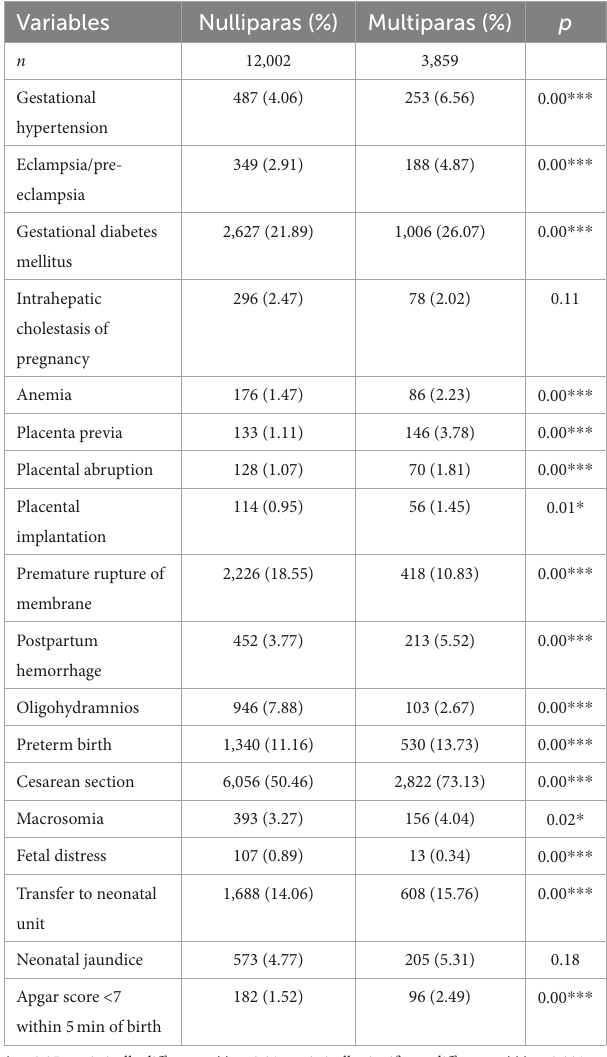
TABLE 3 Incidences of pregnancy outcomes and neonatal outcomes for the single parity group.